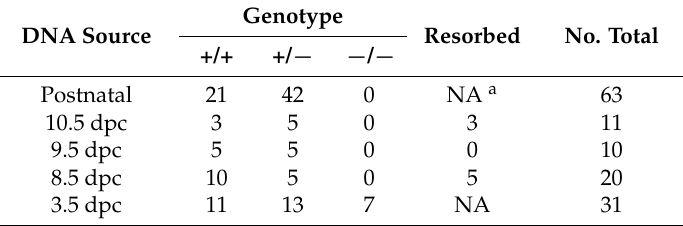
Table 2. Genotype analysis of offspring from dut +/ − intercrosses at different developmental stages. Genotype DNA Source Resorbed No. Total